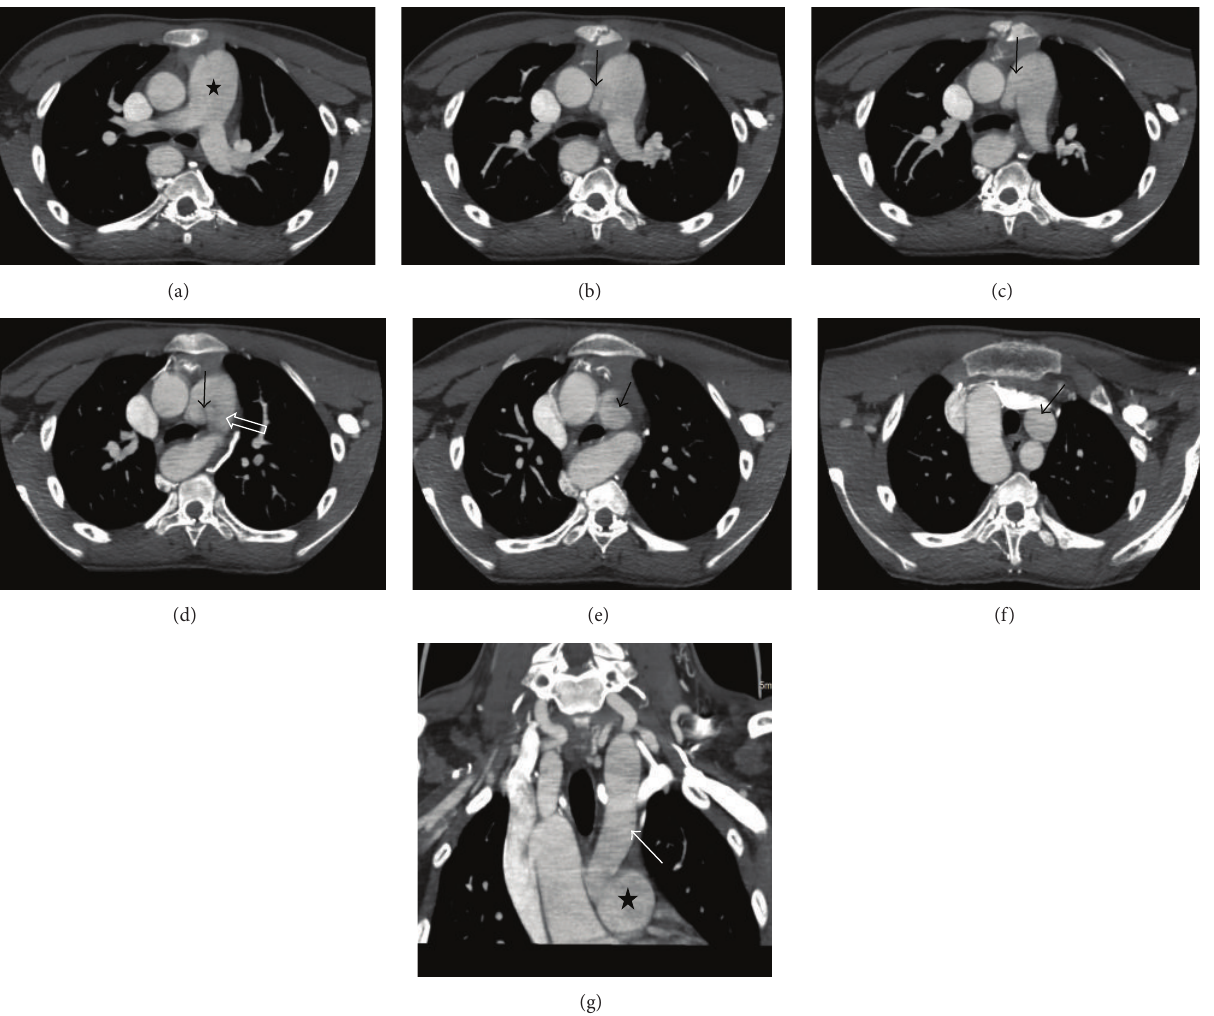
Figure 2: ((a)–(f)) Sequential axial MIP images from the level of bifurcation of MPA (star) superiorly showing origin of left CCA from MPA (black arrow). (d) showing a portion of patent ductus arteriosus (open arrow). (g) Corresponding coronal reconstructed MIP image showing MPA (star) and origin of left CCA from MPA and its dilation